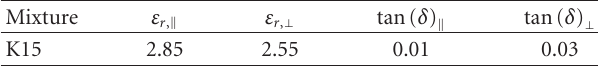
Table 1: Material parameters of K15 and